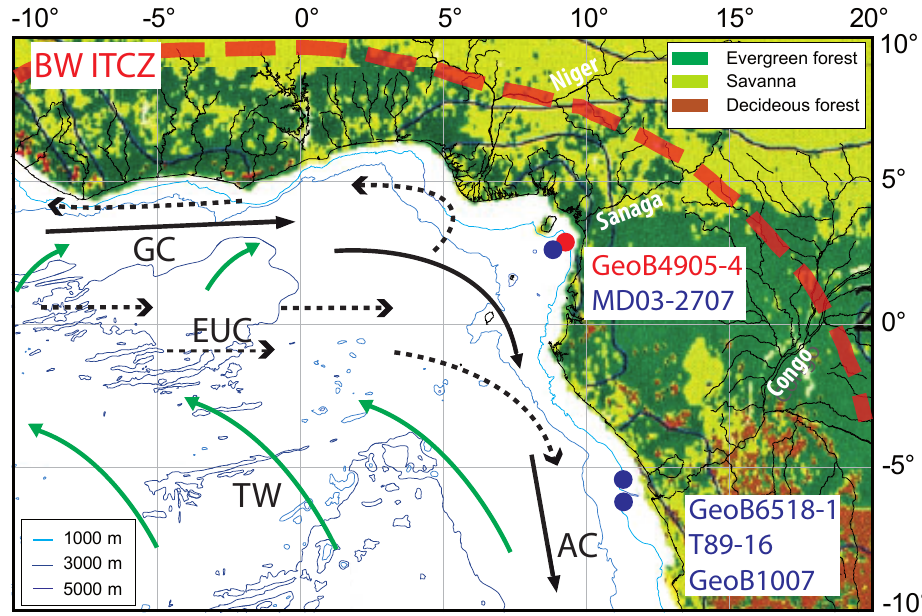
Fig. 1. Bathymetric map of the Gulf of Guinea displaying location of core GeoB4905-4 and other reference sites, along with main surface (plain black arrows) and subsurface currents (dashed black arrows), main atmospheric circulation (green arrows), position of the boreal winter ITCZ (red dashed line), main rivers flowing into the Gulf of Guinea and vegetation distribution in western Equatorial Africa (Foley et al., 2003). The boreal summer ITCZ is located around 15–20 ◦ N (not in figure). GC: Guinea Current; AC: Angola Current; EUC: Equatorial Undercurrent; TW: Trade